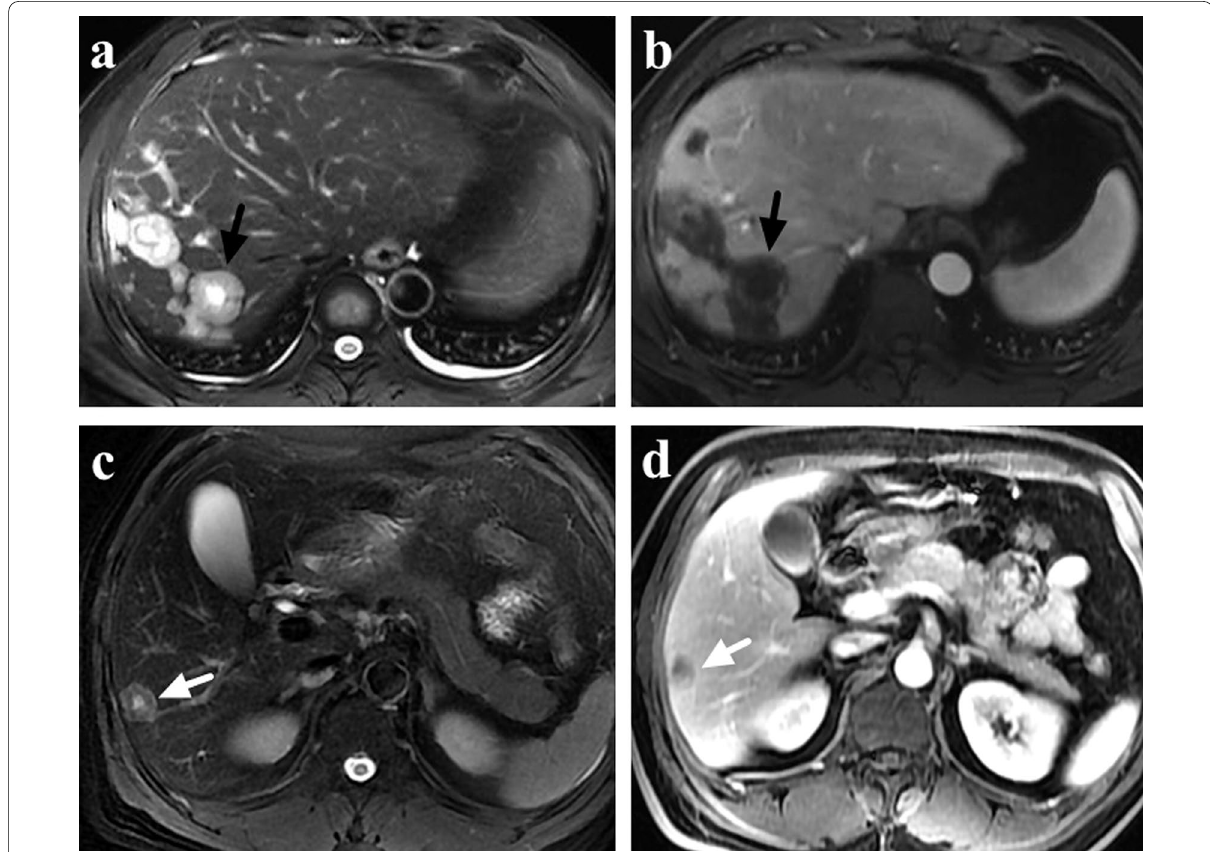
Fig. 8 a, b A 40-year-old male HEH patient with coexistence of target appearance on both T2 weighted and portal phase images. a Target sign on fat-saturated T2-weighted image, consisted of concentric layers including markedly hyperintense in central tumor regions and moderately hyperintense peripheral zone (arrow). b Target sign on portal phase image, consisted of concentric layers including markedly hypointense in central tumor regions and peripheral zones which were moderately hypointense relative to liver parenchyma (arrow). c, d A 51-year-old male rectal carcinoma patients with multiple liver metastasis. c A classic target sign on fat-saturated T2-weighted image (arrow). d Heterogeneous enhancement on portal phase image (arrow), instead of target